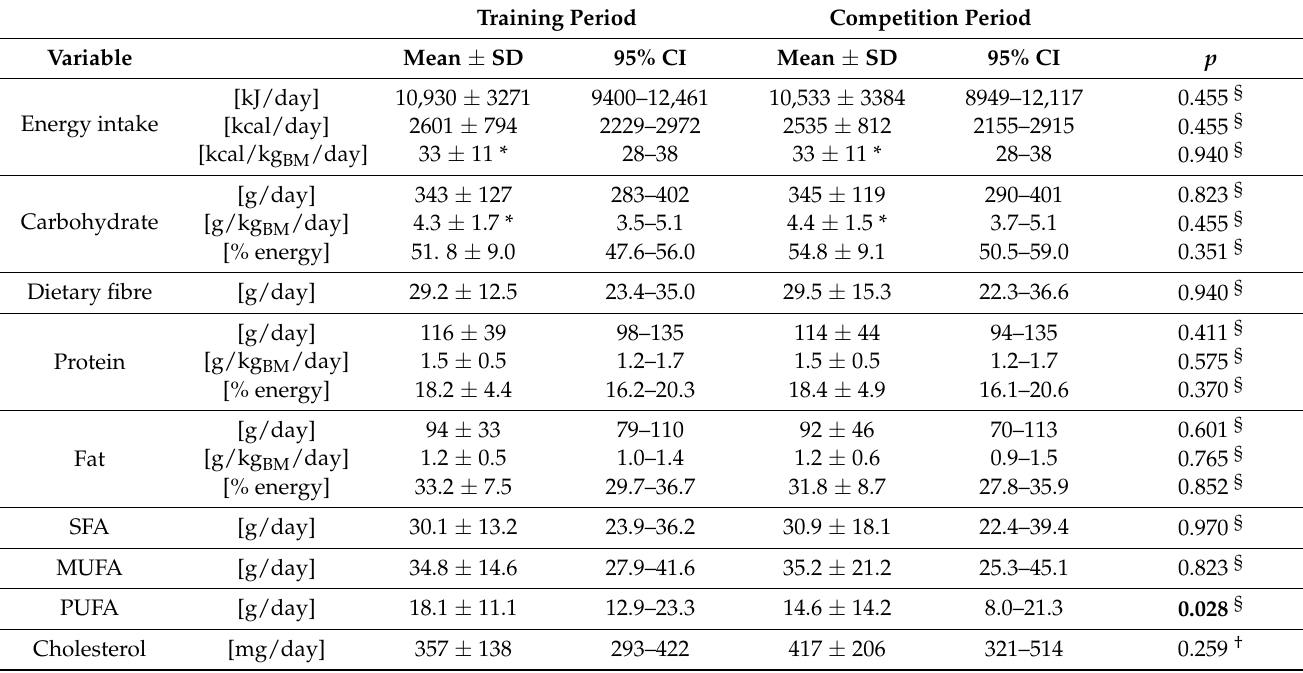
Table 3. Daily energy and macronutrients intake in the diet of triathletes during the training and competition